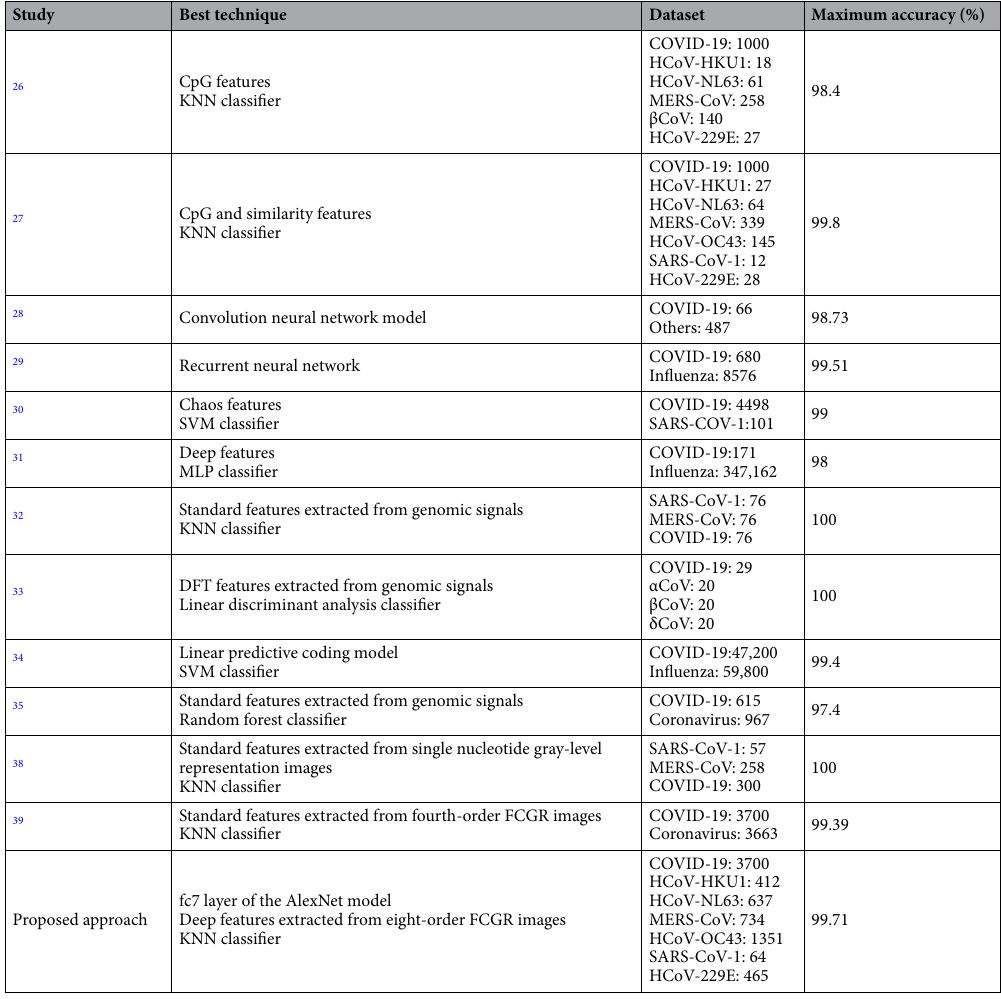
Table 11. Results of the earlier COVID-19 studies. KNN K-nearest neighbors, SVM support vector machine, MLP multilayer perceptron classifier, DFT discrete Fourier transform, FCGR frequency chaos game